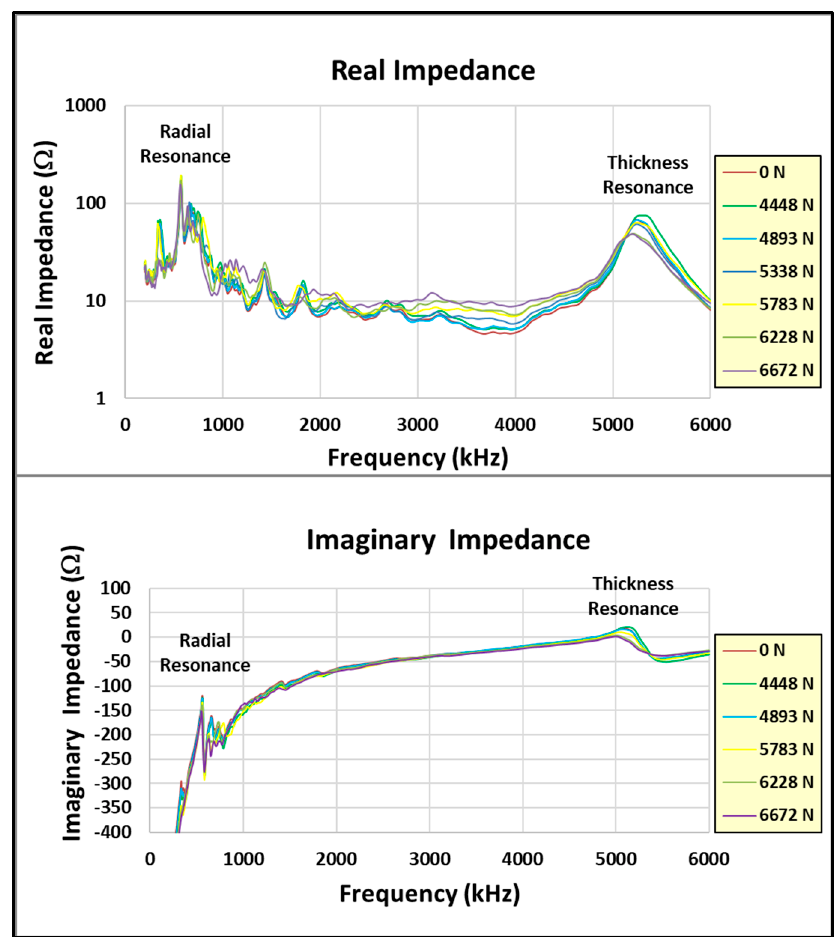
Figure 19. Sensor #11 impedance for each load